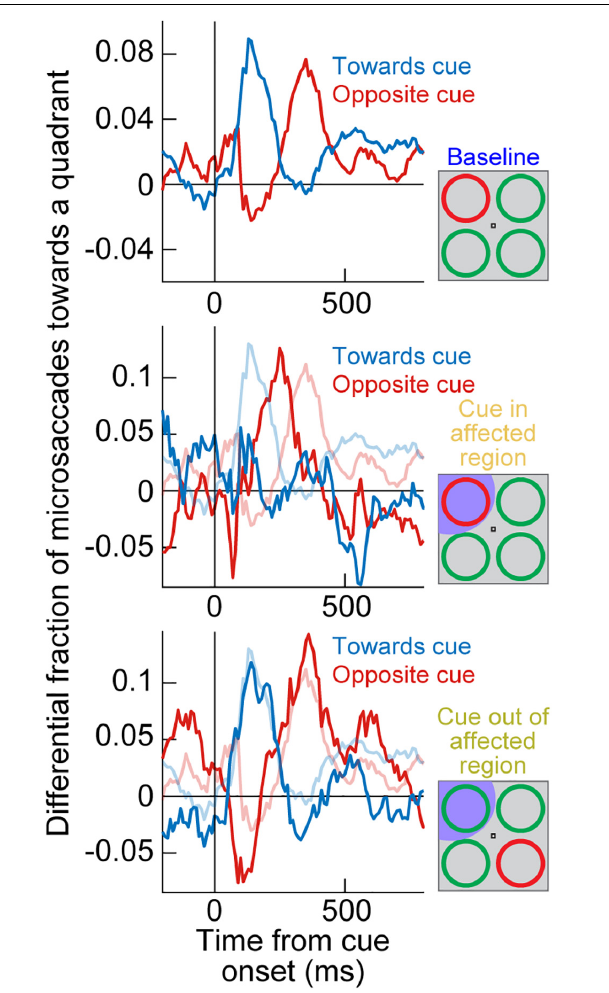
FIGURE 3 | Reversible inactivation of the SC strongly influences cue-induced microsaccade direction oscillations by impairing the propensity for early cue-directed movements. Each panel shows a measure of propensity to generate microsaccades in a certain direction. In the top panel, the singleton cue onset, without SC inactivation, caused a clear microsaccade direction oscillation in the same monkey as in Figure 2 . First, there was an increased likelihood of microsaccades toward the visual quadrant of the cue (blue curve), and then there was an increased likelihood of microsaccades toward the opposite quadrant (red curve). For simplicity, movements to the other two visual display quadrants (the least modulated by the cue) are not shown. This panel was adapted with permission from Hafed et al. (2011). In the middle panel, the cue appeared in the quadrant affected by SC inactivation (see shading in the schematic inset on the right). The early cue-directed microsaccades were massively reduced relative to baseline (blue curve), and oppositely directed microsaccades (red curve) came earlier than in baseline. The baseline curves from the top panel are shown in faint colors for comparison. When the cue was placed opposite the affected region (bottom panel), the direction oscillations were normal again, and very similar to the baseline data without any SC inactivation (faint colors). Therefore, cue-incongruent microsaccades after microsaccadic inhibition (e.g., Figure 1 ) are not affected by SC inactivation (even when they are still directed toward the affected quadrant, as in the bottom panel); only the earlier cue-congruent microsaccades are affected when the cue is in the impaired display region. The middle and bottom panels are adapted with permission from Hafed et al.